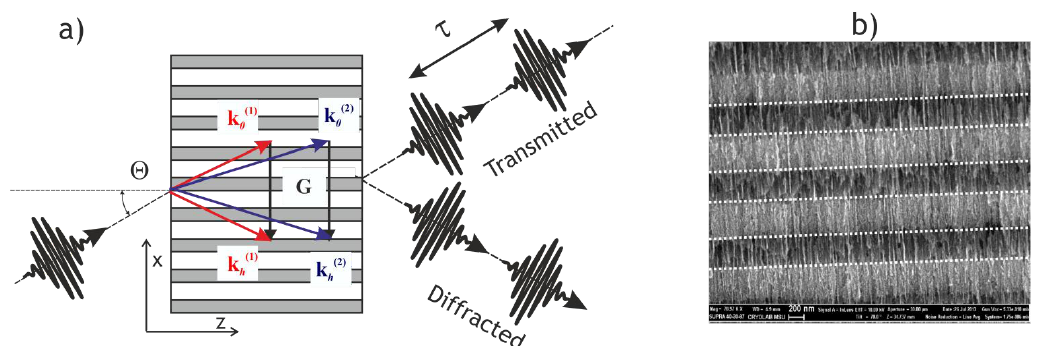
Figure 1. ( a ) Scheme of the dynamical Bragg diffraction and of the temporal pulse splitting in the direct and diffraction directions; ( b ) SEM image of the cross-section of the porous silicon based